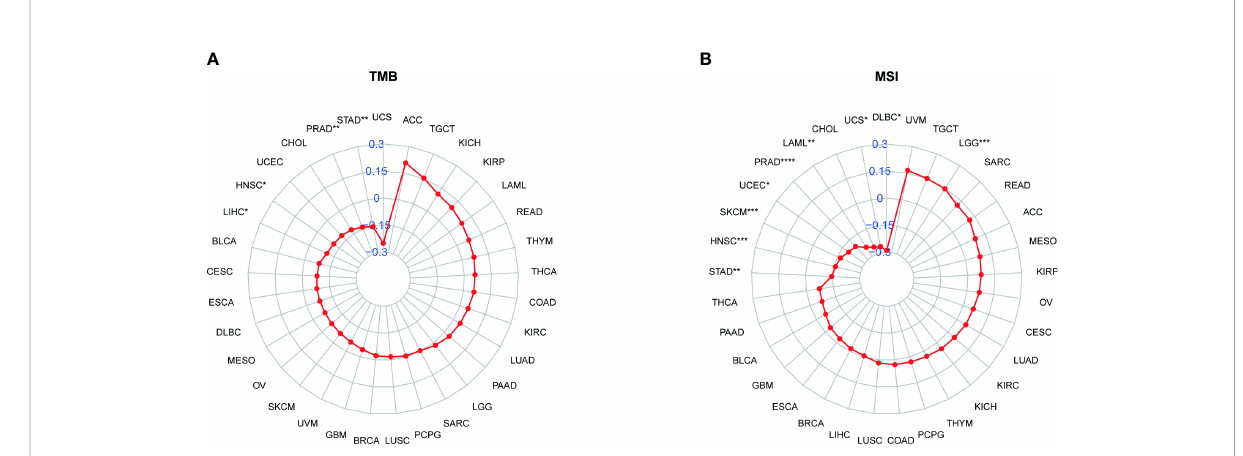
FIGURE 11 Relationship between PXDN expression and TMB and MSI. (A) Radar plot of the correlation between PXDN expression and TMB in different tumors. (B) Radar plot of the correlation between PXDN expression and MSI in different tumors. *p < 0.05, **p < 0.01, ***p < 0.001, ****p <